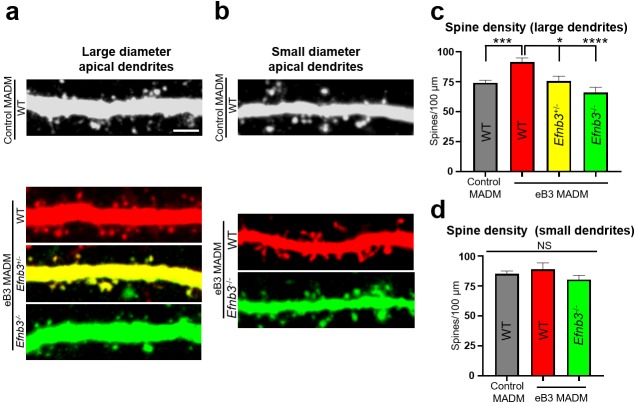
Relative levels of ephrin-B3 control spine density in vivo.(a) Representative large diameter (>1.6 μm) dendrites of subgranular pyramidal neurons in control and eB3 Nestin-spCre MADM mice. Scale bar, 3 μm. (b) Representative small diameter (<1.6 μm) dendrites of subgranular pyramidal neurons in control and eB3 Nestin-spCreMADM mice. (c) Quantification of spine density on large diameter dendrites from neurons in control and eB3 MADM mice (control MADM (WT), n=93; eB3 MADM tdTomato+ (WT), n=50; eB3 MADM tdTomato+/EGFP+ (Efnb3+/-), n=24; eB3 MADM EGFP+ (Efnb3-/-), n= 38; F(3, 201)= 10.40, p<0.0001, one-way ANOVA, ****p<0.0001, ***p=0.0011 *p<0.05, Tukey’s post hoc.) (﻿d) Quantification of spine density on small diameter dendrites from neurons in control and eB3 MADM mice (control MADM, n=48; eB3 MADM TdTomato+ (WT), n=19; eB3 MADM EGFP+ (Efnb3-/-), n= 33; F(2, 97)= 1.283, p=0.2818, one-way ANOVA).10.7554/eLife.41563.022Figure 6—source data 1.Relative levels of ephrin-B3 control spine density in vivo.